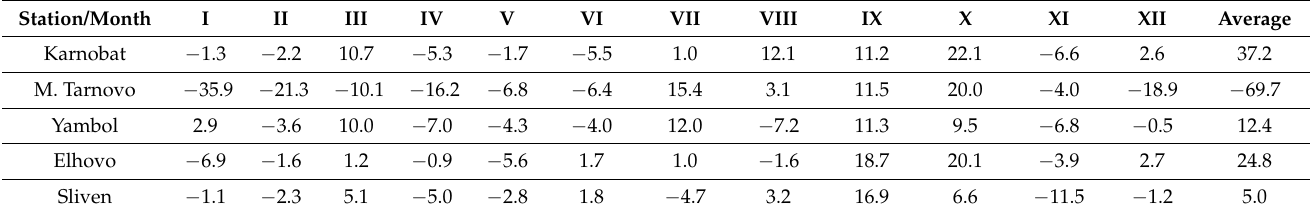
Table 9. Average monthly sums of rainfall deviations in southeastern Bulgaria for the period